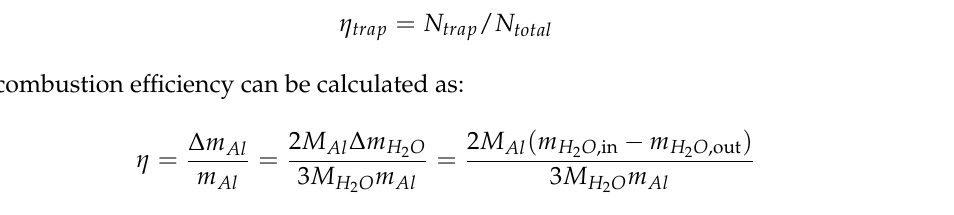
Figure 10. Burning time distribution of Al particles.